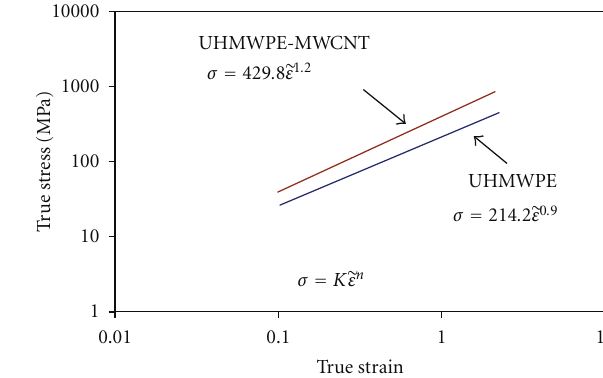
Figure 3: Cyclic true stress-strain hysteresis curves for neat and nanophased UHMWPE filament.